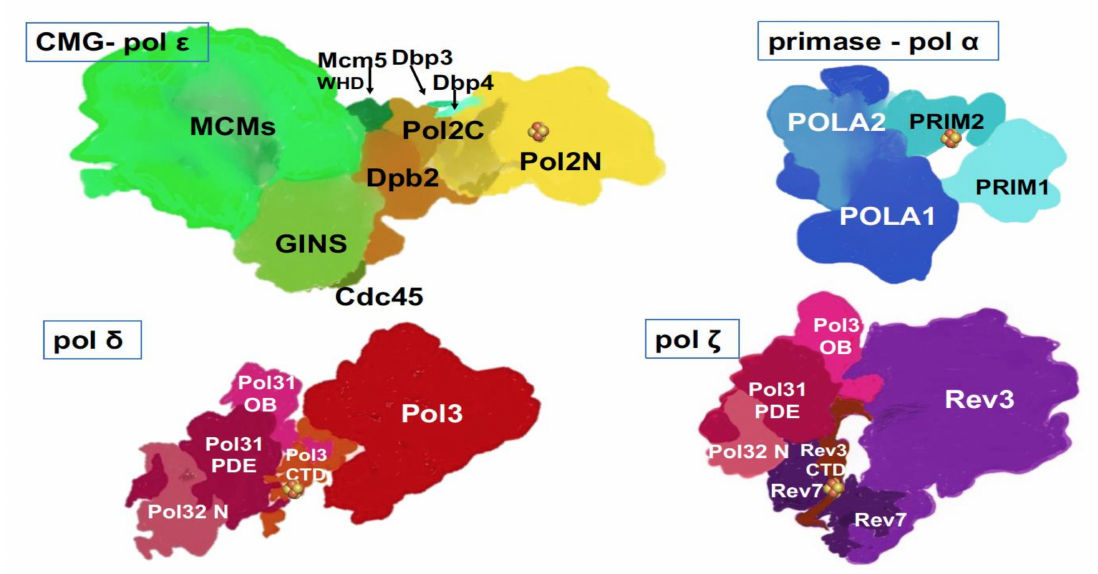
Figure 3. Multi-subunit replicative DNA pols. Artistic representations were made based on crystal and cryo-EM structures and models of human primase-pol α [58], yeast pol ε [65,67], yeast pol δ [60], yeast pol ζ [66]. Two latter structures were determined with a truncated third subunit (Table 1), Pol 32, without the C-terminal part, and thus, this part is missing from our drawings. Fe-S cluster ( ) is present in each of the four pol